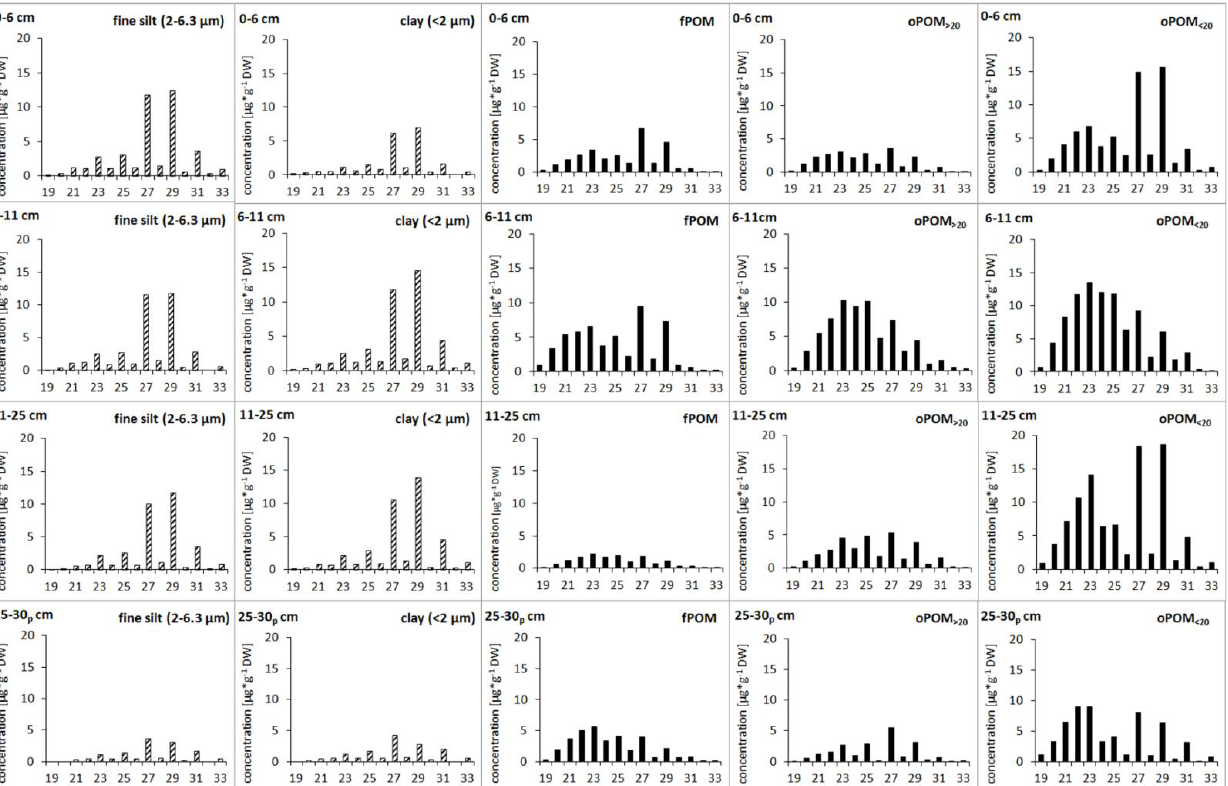
Fig. 3. n -alkane concentrations in fine silt and clay (striped bars) and in three density fractions (black bars) from different depths intervals. Only odd n -alkanes are labelled on the x-axis.